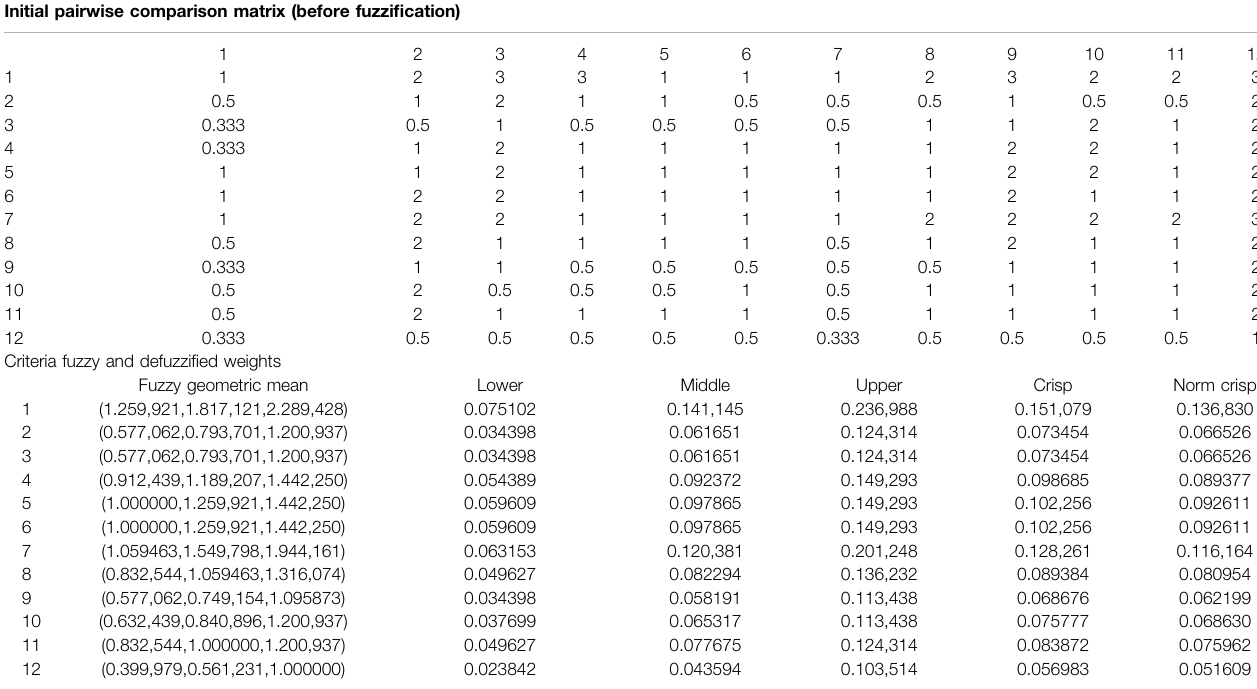
TABLE 3 | Fuzzy AHP results per criteria category – Category Technological. Initial pairwise comparison matrix (before fuzzi fi cation)